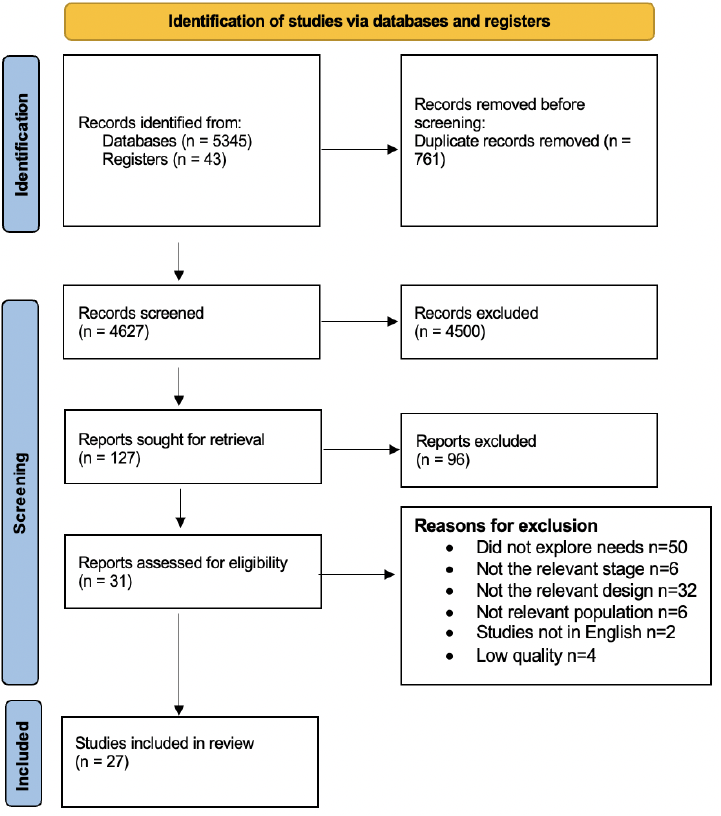
Figure 1. The PRISMA flow diagram.